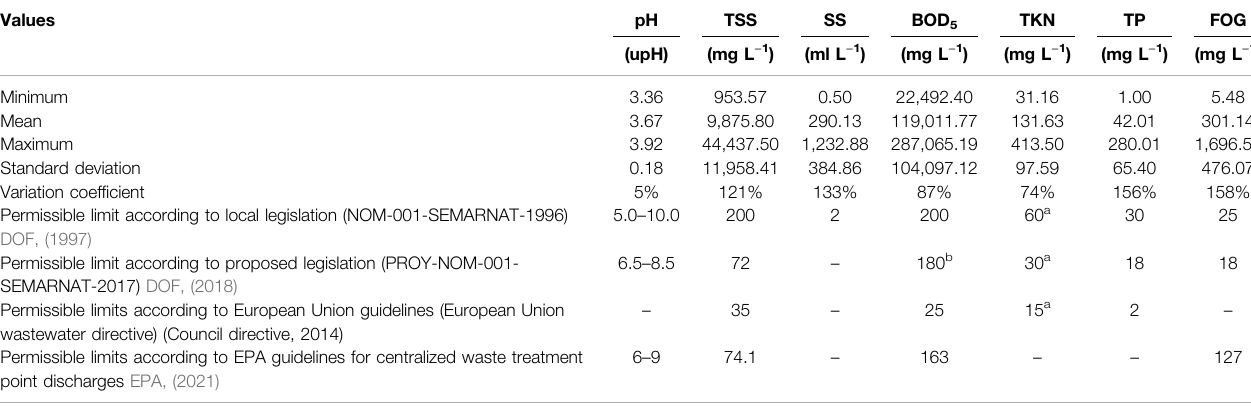
TABLE 6 | Physicochemical characterization of the sampled vinasses.